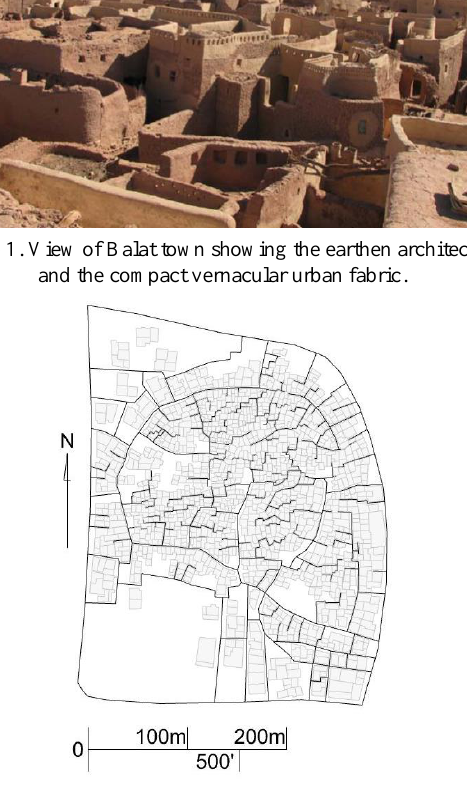
Figure 2. The central area of Balat.